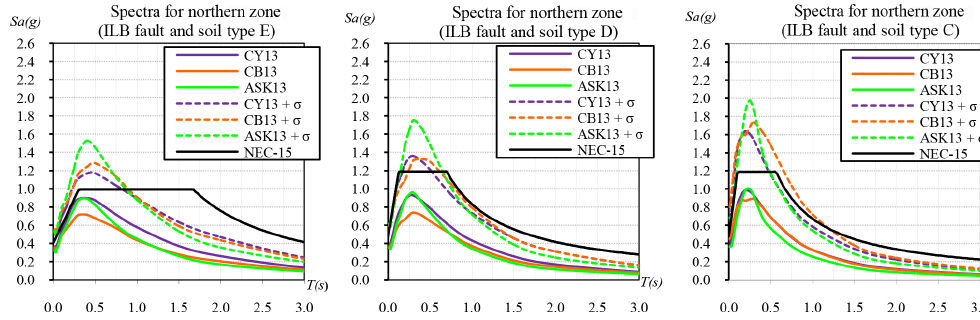
Figure 6. Spectra for the northern zone of Quito.